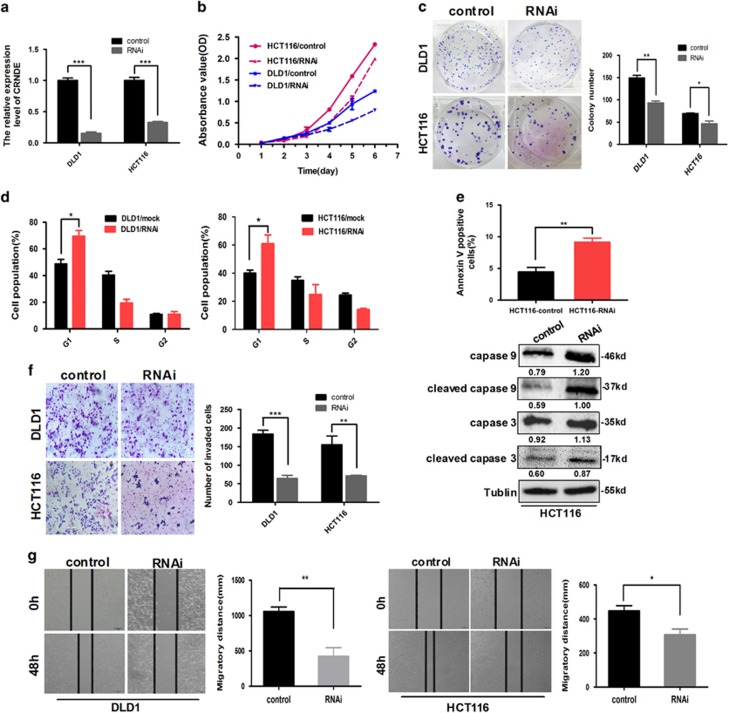
CRNDE depletion inhibits cell proliferation, cell cycling, invasion and migration in CRC cells in vitro. (a) DLD1 and HCT116 cells were infected with Lv-siCRNDE to establish two cell lines with stable knockdown of CRNDE expression. CRNDE levels in DLD1 and HCT116 cells after shRNA-mediated knockdown of CRNDE were detected by real-time RT-PCR. (b) CCK-8 assays were performed to determine the proliferation of CRNDE-depleted CRC cells. (c) Colony-forming assays were performed to determine the effects of CRNDE depletion on the growth of CRC cells. (d) Cell cycle progression was analyzed by flow cytometry. (e) Apoptosis assays were performed to determine the effects of CRNDE depletion on CRC cells by flow cytometry (upper) and by western blot analysis (lower). (f) Matrigel invasion assays were used to determine the effects of CRNDE depletion on the invasion ability of CRC cells. (g) Scratch-wound-healing assays were performed to determine the effects of CRNDE depletion on the migration ability of CRC cells. The experiments were performed in triplicate, and the data are expressed as the mean±S.D. *P<0.05, **P<0.01 and ***P<0.001